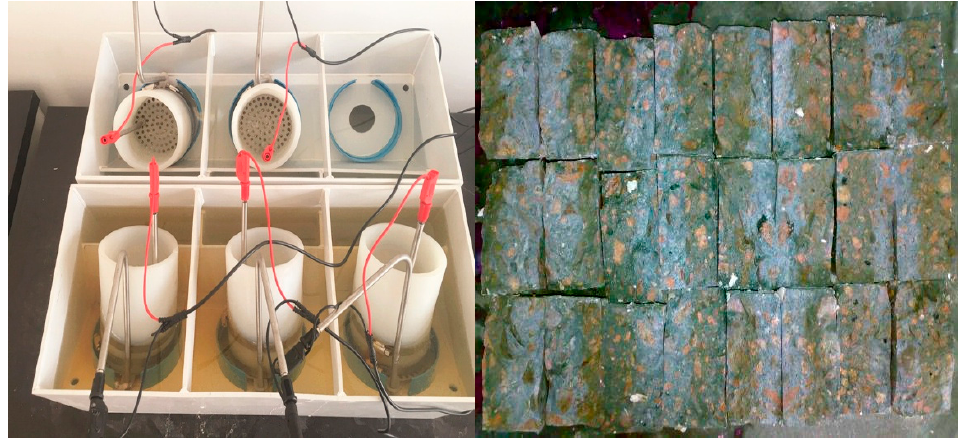
Figure 6. Cl − penetration device and testing specimens.